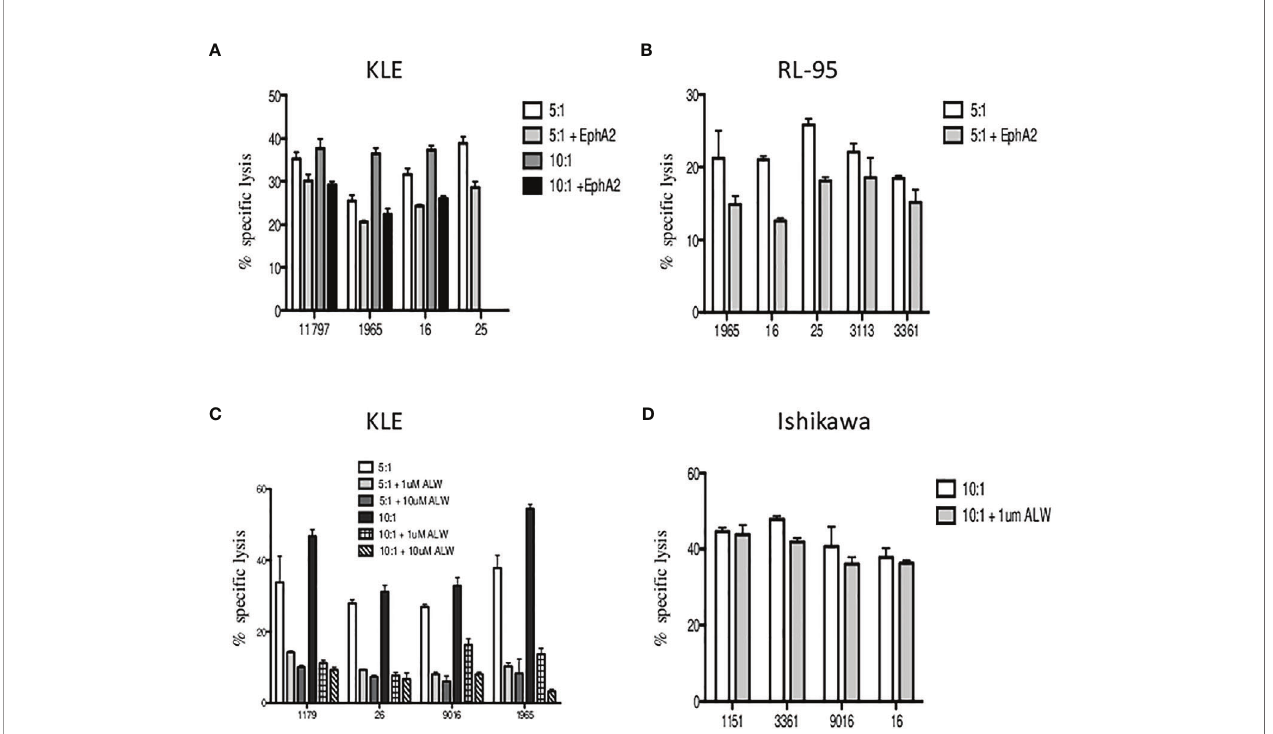
FIGURE 6 | The inhibition of V d 1 T-cell-mediated killing by blocking of EphA2 expression on endometrial tumor cells. The target cells were preincubated with the EphA2 antibody prior to 4 h cytotoxicity assays and the speci fi c lysis of KLE (A) and RL95-2 (B) cells was determined at 5:1 and 10:1 E:T ratios. Summary data of speci fi c lysis and cytotoxicity reduction in the presence of EphA2 antibody is shown as the mean ± SD of independent experiments performed in duplicates (HD numbered anonymously). (C) Analysis of the in vitro effects of the small-molecule inhibitor ALW-II-41-27 at 1 and 10 µM on KLE endometrial tumor cells. Dose- dependent inhibition of cytotoxicity by V d 1 T cells is shown at 5:1 (pale grey bars) and 10:1 (dark grey bars) E:T ratios. (D) V d 1 T-cell-mediated killing of EphA2- negative Ishikawa endometrial cell line was analyzed at 10:1 E:T with/without the presence of small-molecule inhibitor ALW-II-41-27 (1 µM) and is shown as the mean ± SD of independent experiments performed in